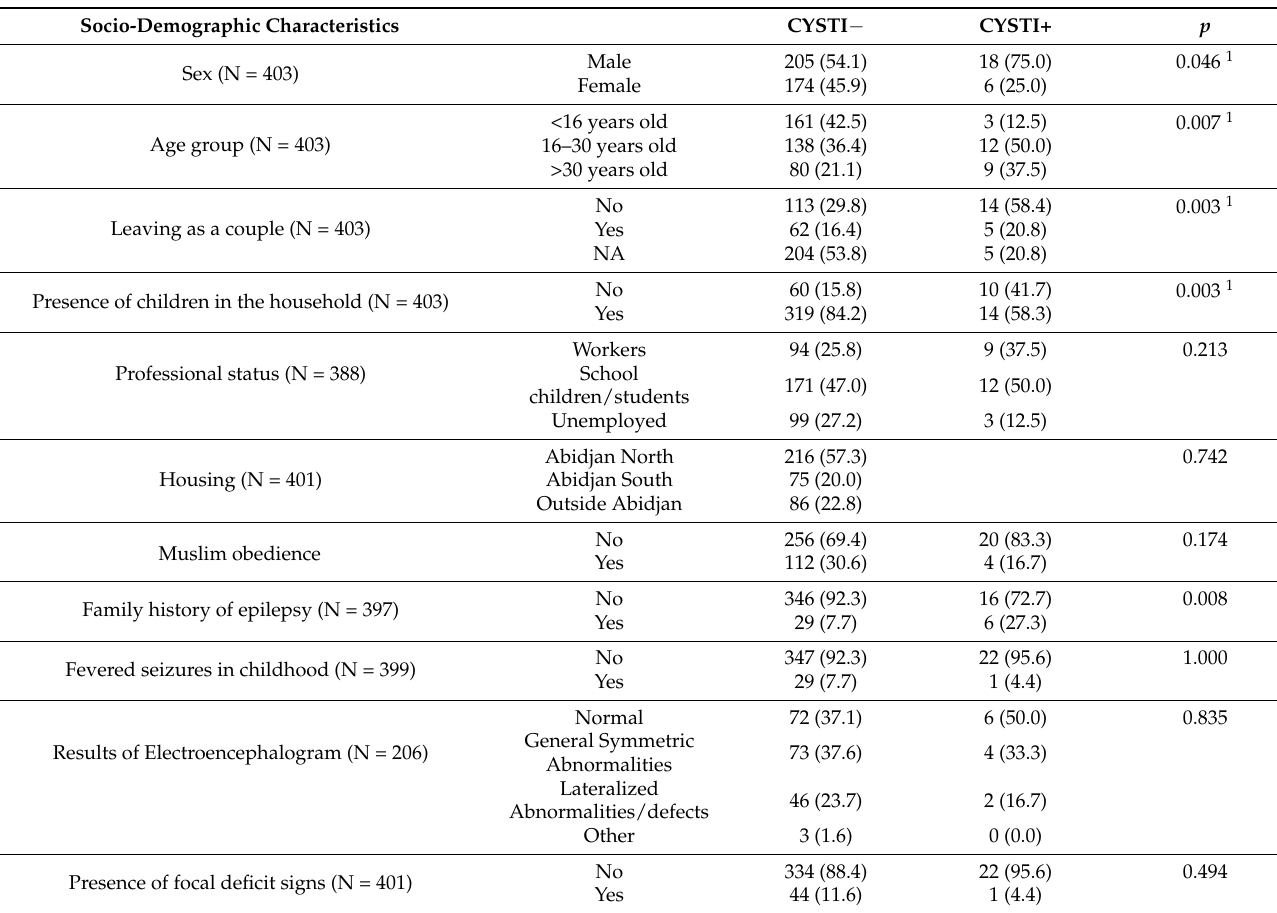
Table 2. Socio-demographic and clinical characteristics of epileptic patients included in the study by cysticercosis serological status. Socio-Demographic Characteristics